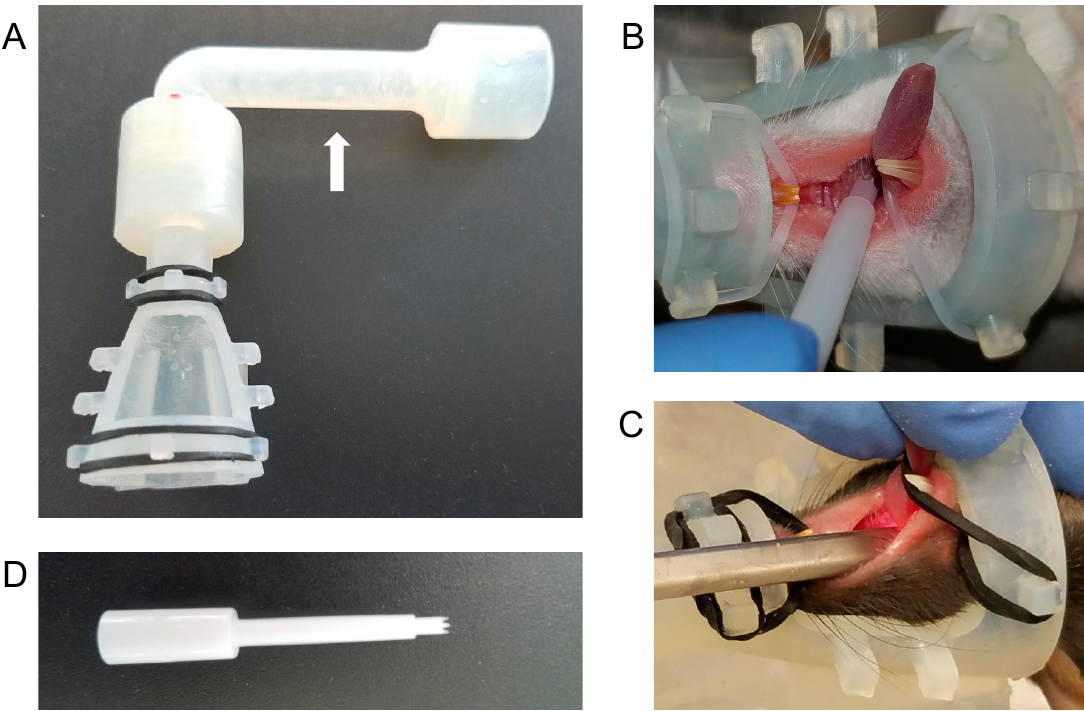
Figure 1. “Mickey’s Space Helmet” maintains isoflurane anesthesia during oral procedures. ( A ) The oral-access isoflurane nose cone was generated by three-dimensional (3D) printing using the bleach-resistant “Durable Resin.” The elbow adapter (white arrow) bears a small “tooth” that slides into a groove in the port at the top of the cone. This groove is at 90° to, and continuous with, a second circular groove that allows 360° rotation of the adapter relative to the cone. ( B ) The cone can be used with elastic bands (shown: silicone o-rings) to keep the mouth open via the incisors during infection with the Greer Pick. The tongue can also be restrained using the mandibular band, as shown. ( C ) The cone is also compatible with endoscopy. ( D ) The Greer Pick.